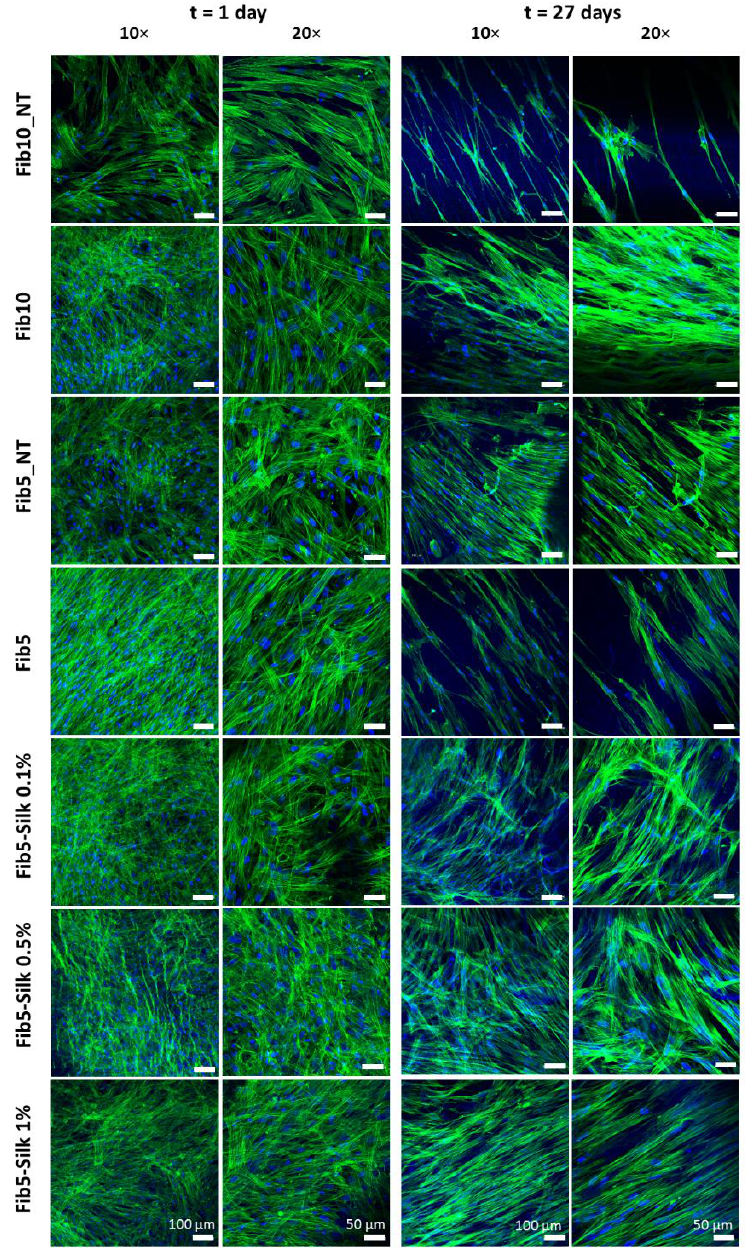
Figure 8. Confocal images of the scaffolds cultured with human arterial smooth muscle cells (HUASMCs) at two different time points: 1 day and 27 days. Actin filaments of the cell cytoskeleton appear in green (phalloidin staining) and nuclei in blue (DAPI staining).